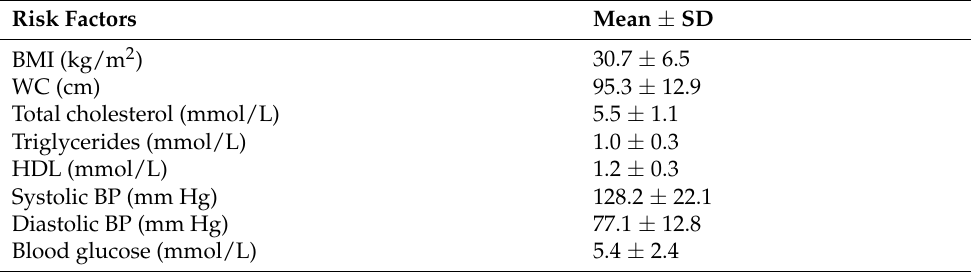
Table 2. Presence of anthropometric and cardiometabolic risk factors.